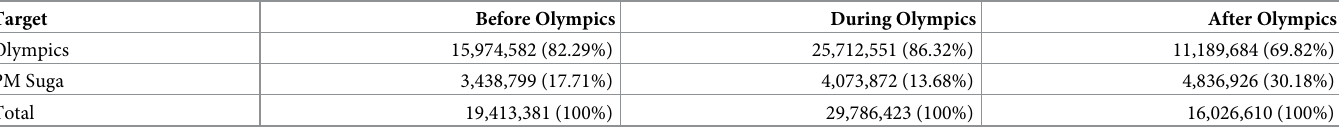
Table 1. Number of tweets.